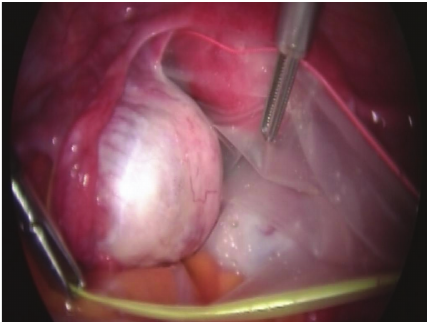
Figure 1: Cyst-harboring adnexa inside handle-free endoscopic